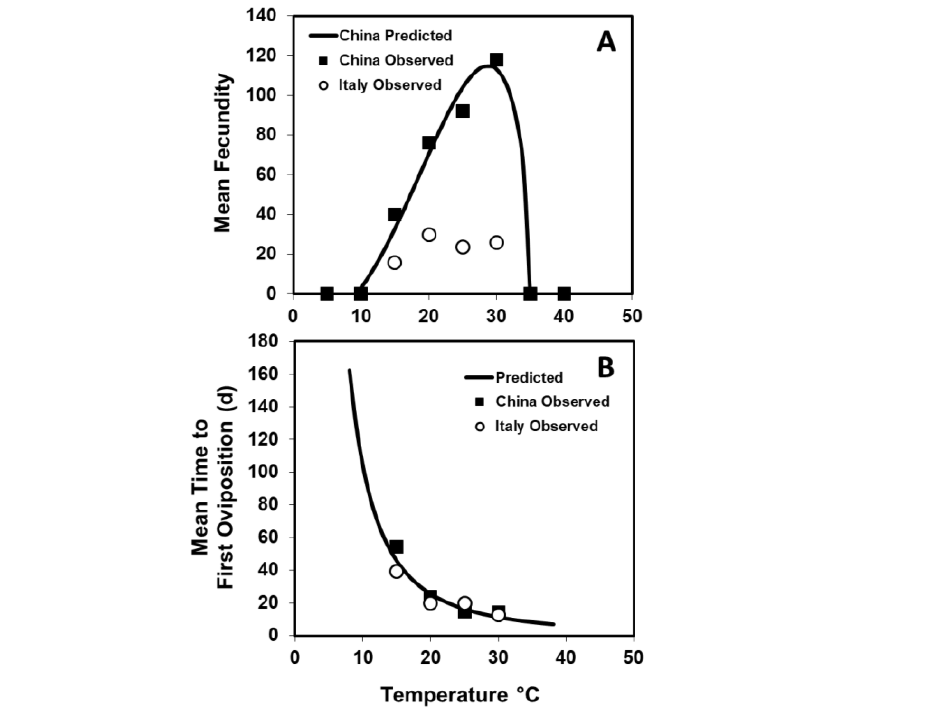
Figure 3. Relationships between temperature and mean fecundity ( A ) and time to oviposition ( B ) for A. chinensis from China (solid squares) and Italy (open circles). The solid line in graph A is for only the Chinese population, and in graph B it is for the two populations combined.